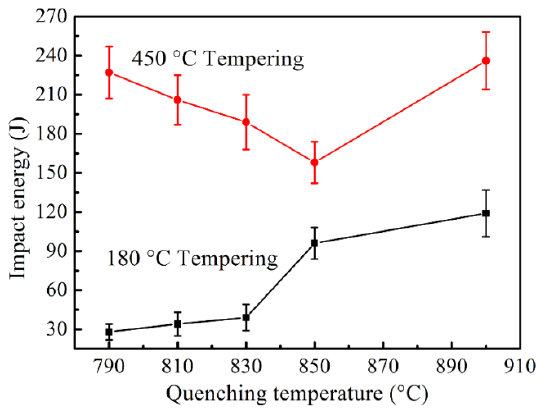
Figure 9. −40 °C Charpy V-notched impact energy versus quenching temperature of the specimens Figure 9. − 40 ◦ C Charpy V-notched impact energy versus quenching temperature of the specimens tempered at 180 °C and 450 °C, respectively. tempered at 180 ◦ C and 450 ◦ C, respectively. Materials 2018 , 11 , x FOR PEER REVIEW